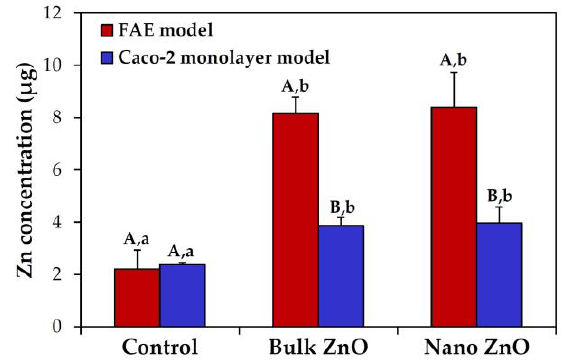
Figure 6. Intestinal transport of bulk and nano ZnOs using an in vitro human follicle-associated epithelium (FAE) model and a Caco-2 monolayer model. Different capital (A,B) and lower case (a,b) letters indicate significant differences between the FAE and Caco-2 monolayer models and among untreated control, bulk ZnO, and nano ZnO, respectively ( p < 0.05).